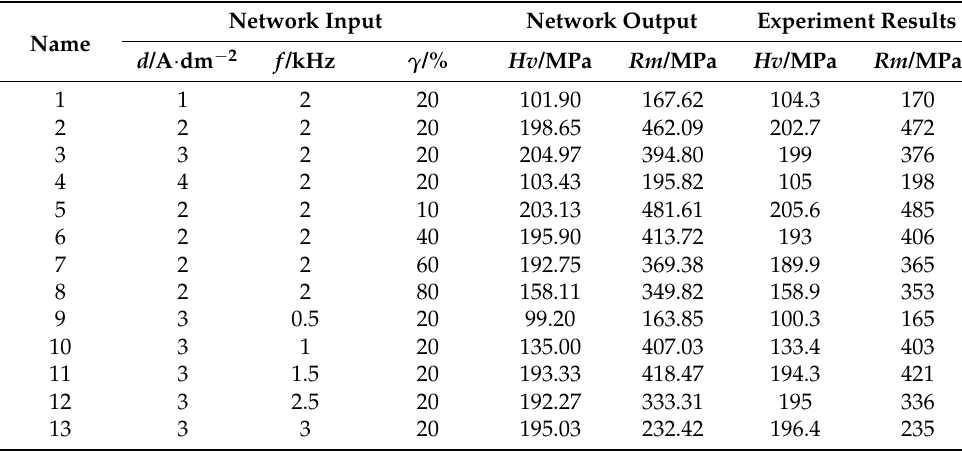
Table 5. The comparison of BP NN prediction with experimental